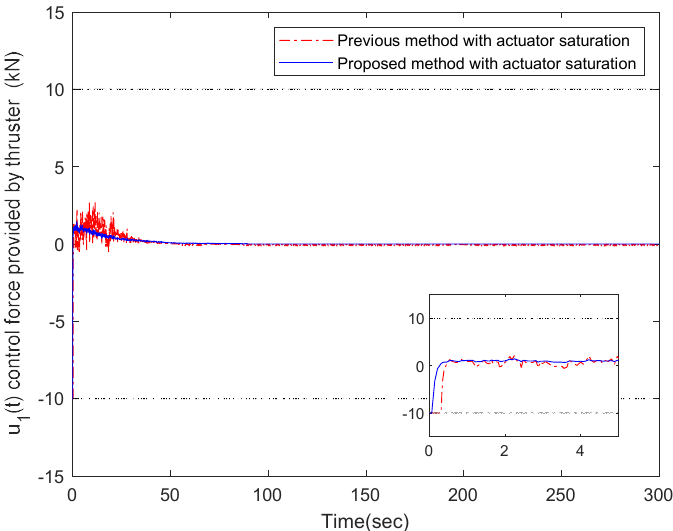
Figure 10. The responses of u 1 ( t ) compared with [29].